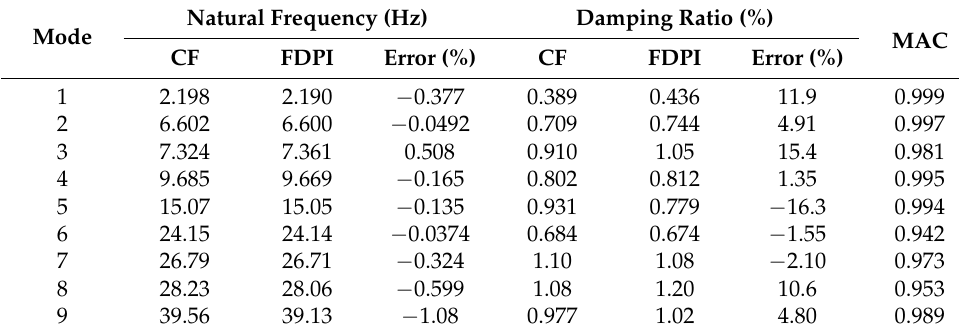
Table 4. Estimated modal